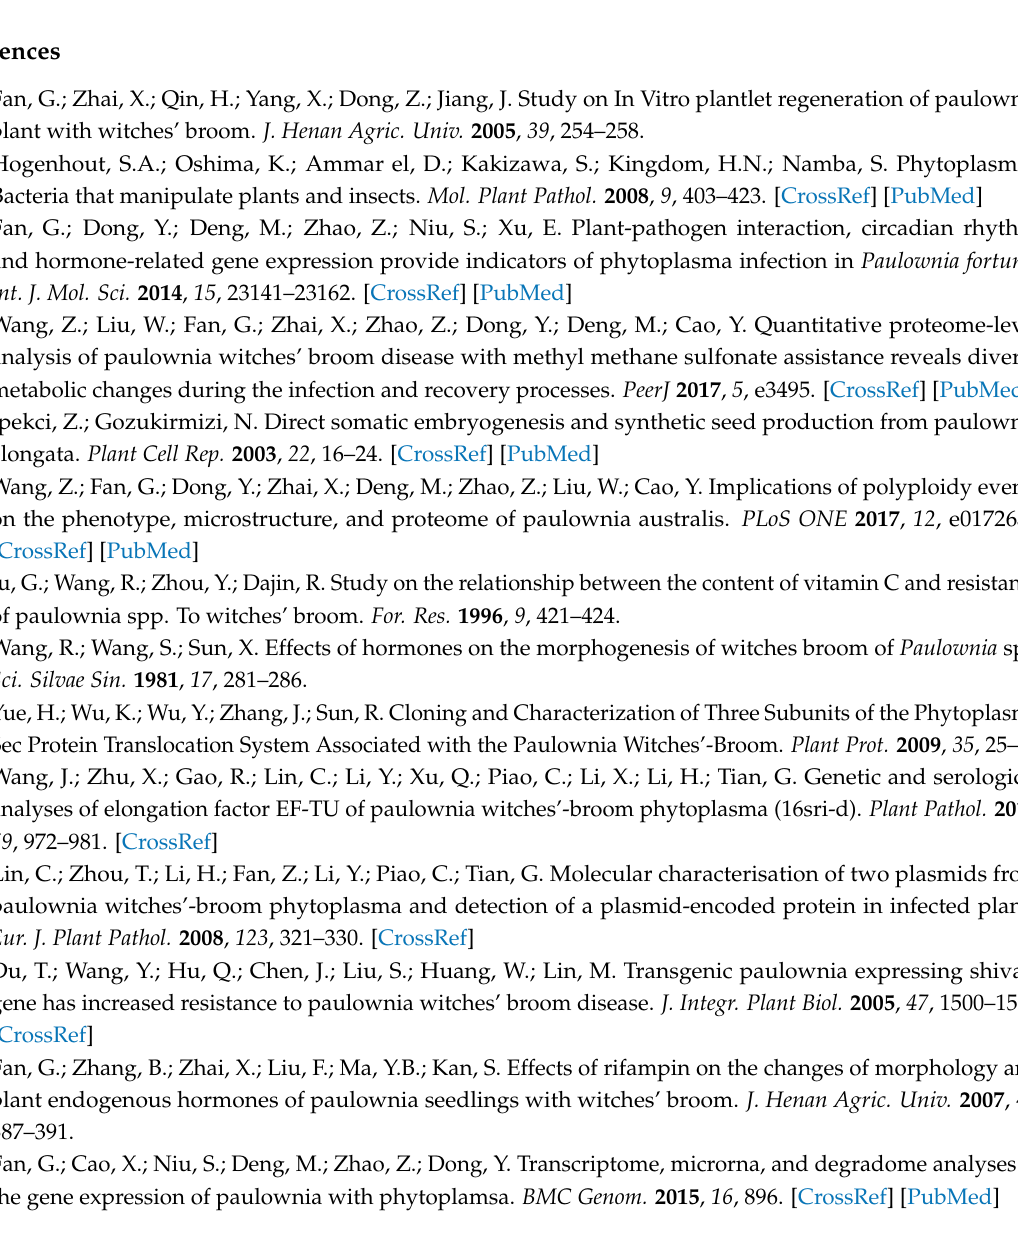
Table S3: The revealed lncRNAs in this study. Table S4: Classification of predicted lncRNAs into different ncRNA families. Table S5: The conservation of Paulownia lncRNAs. Table S6: The identified target genes in this